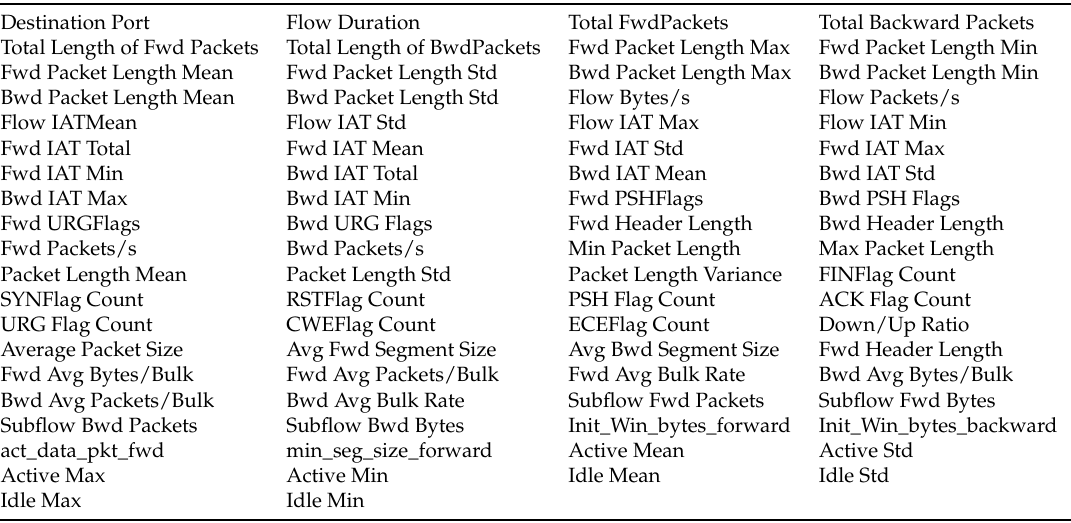
Table 1. Network flow features of the CICIDS2017